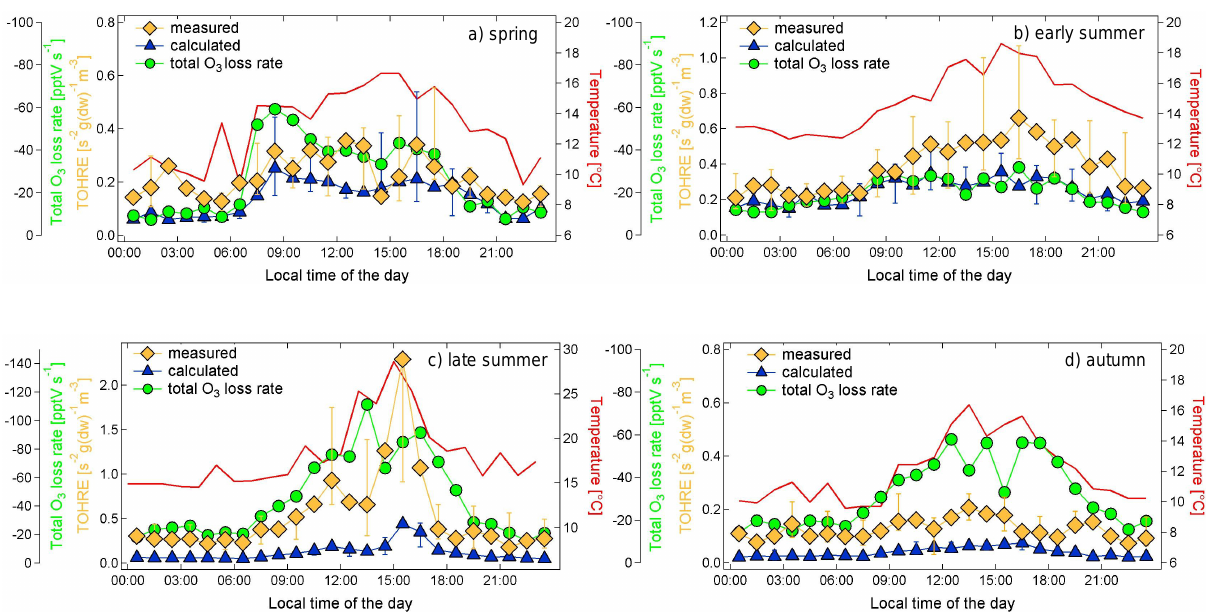
Fig. 6. Median diel profiles for four periods (a) spring, (b) early summer, (c) late summer, (d) early autumn of total OH reactivity emissions (TOHRE) that were measured by CRM (orange markers) and calculated from PTR-MS data (blue markers) and of the observed total ozone loss rate (green markers). Additionally, the median temperature profile is included (red line). Uncertainties of the hourly median are given for measured and calculated TOHRE as 75 and 25 percentiles.